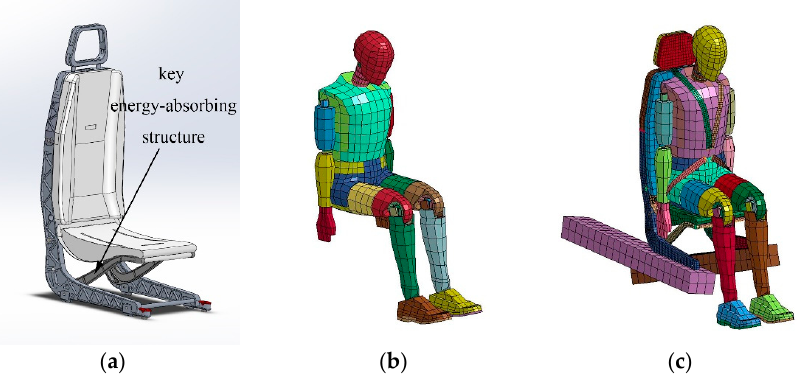
Figure 1. Three-dimensional models. ( a ) The seat. ( b ) The simplified FEM model of Hybrid III 50th Percentile ATD. ( c ) The human–seat coupling